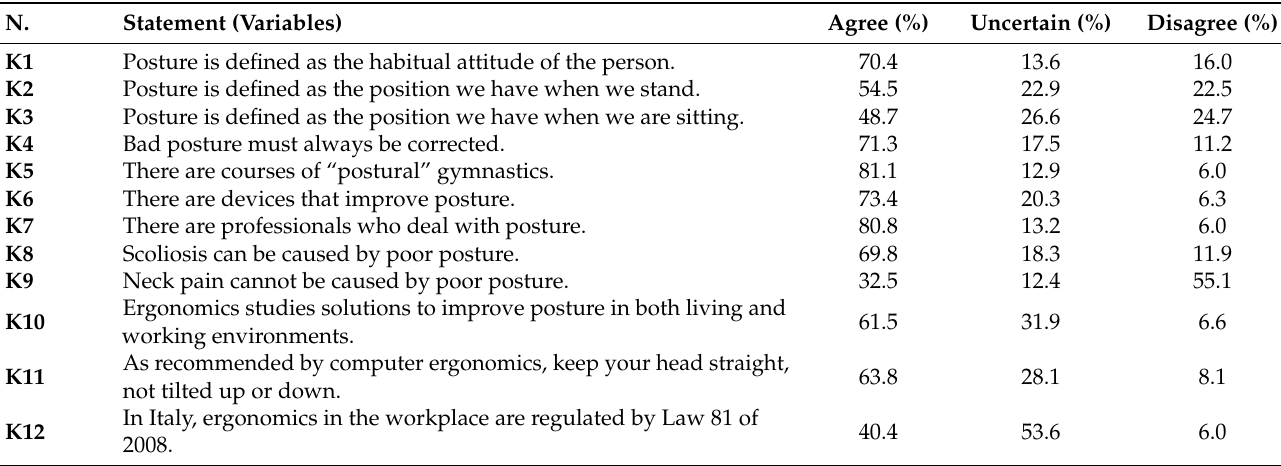
Table 2. Knowledge of respondents toward the